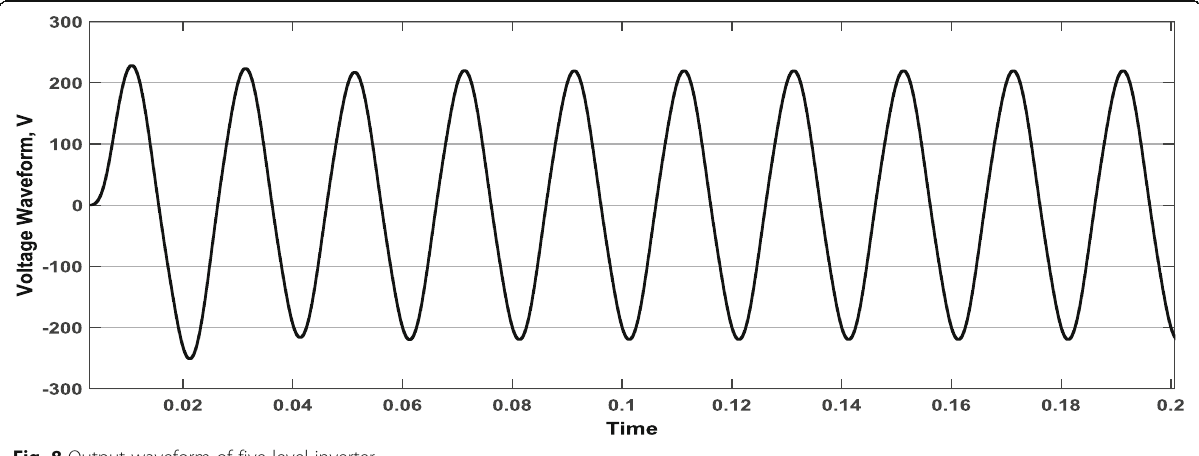
Fig. 8 Output waveform of five level inverter